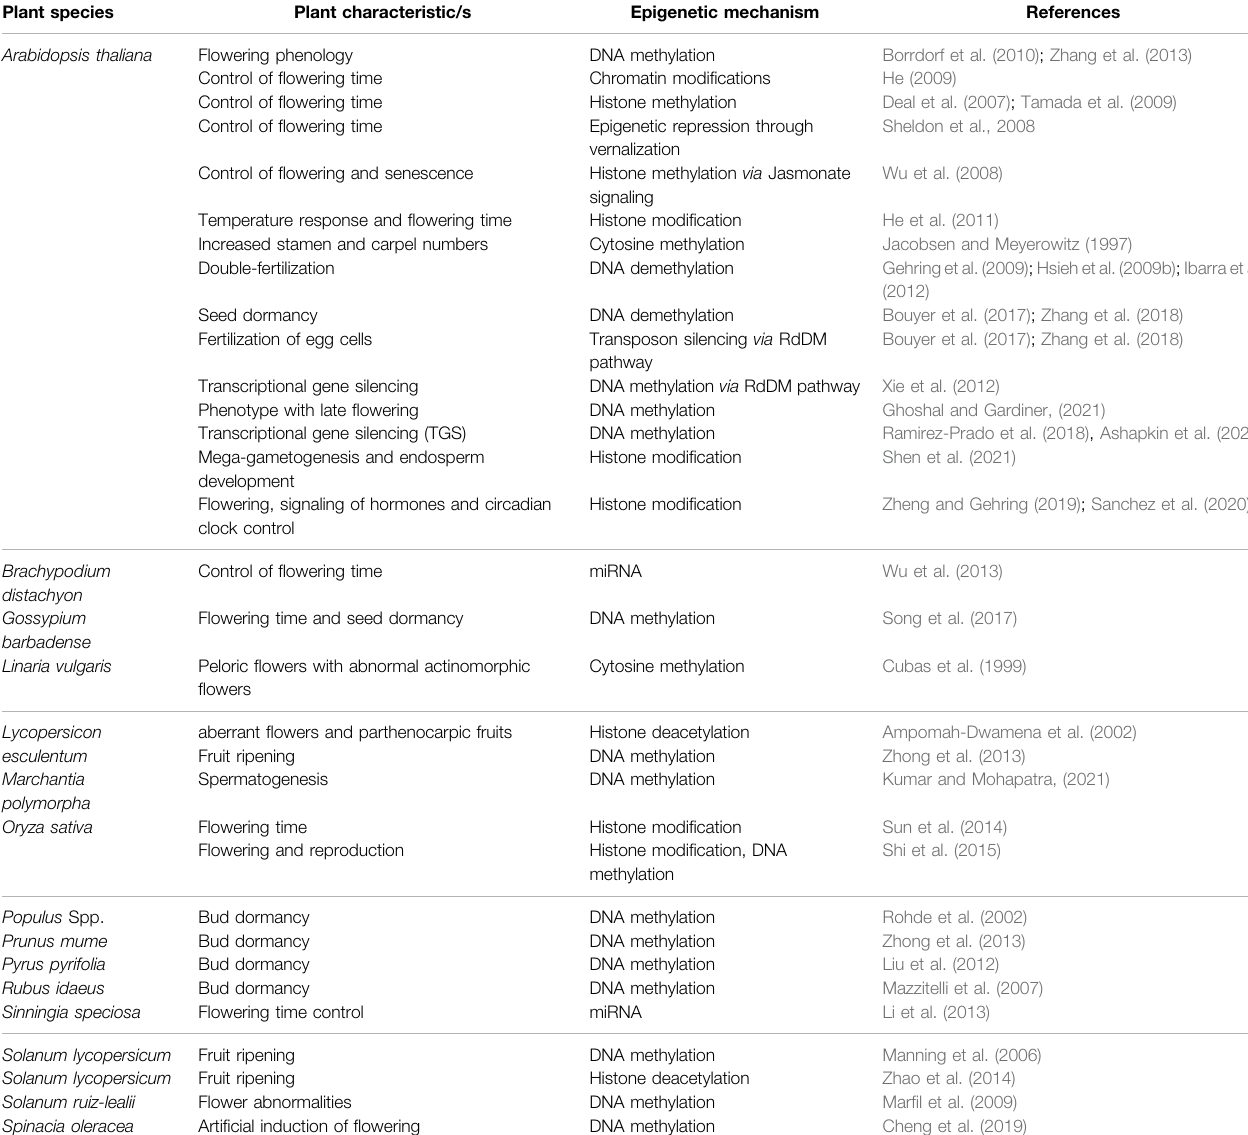
TABLE 3 | Role of epigenetically induced modi fi cations in reproduction of different plant species. Plant